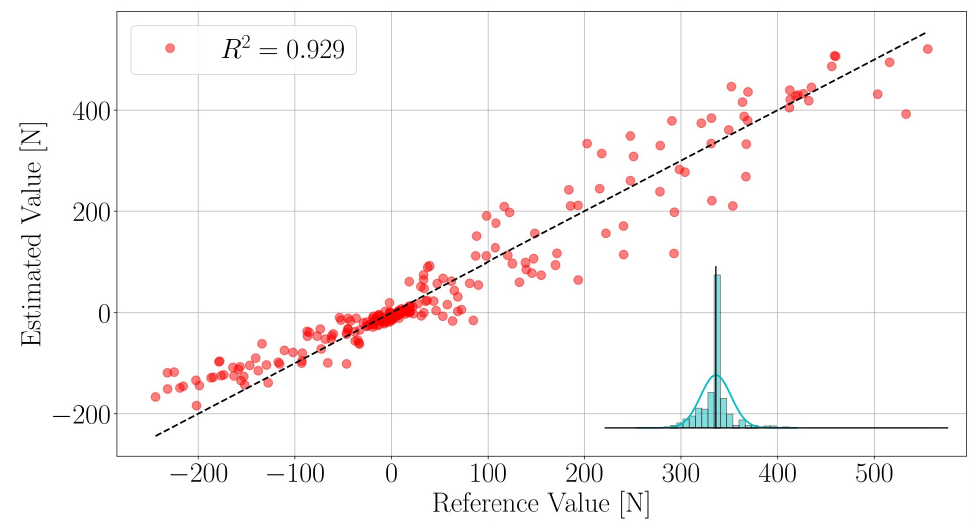
Figure 8. Force F z model performance on test data set. The histogram represents the error e = F z − ˆ F z distribution—the black vertical line is located at e = 0, the bins have size 6.15N. Table 1. Force sensor calibration